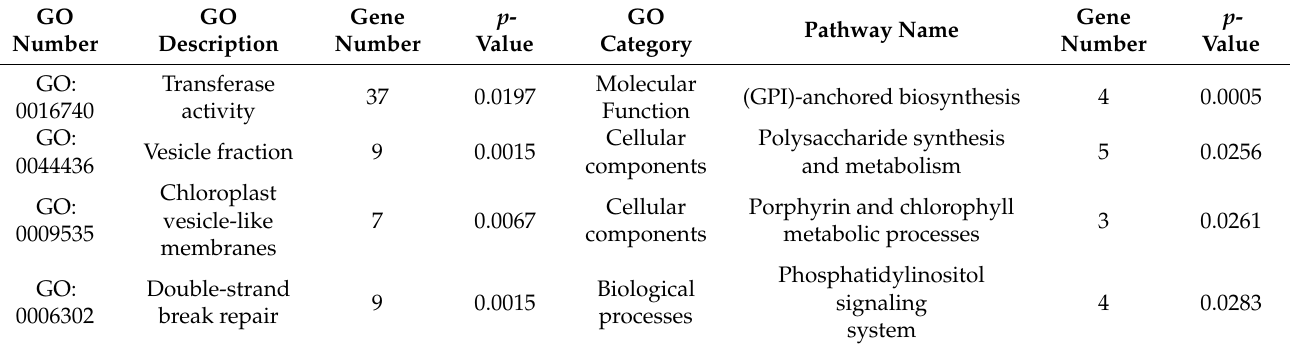
Table 6. CK versus NaCl + ALA comparator group-specific differential alternative splicing genes significantly enriched in GO entries and KEGG pathway.